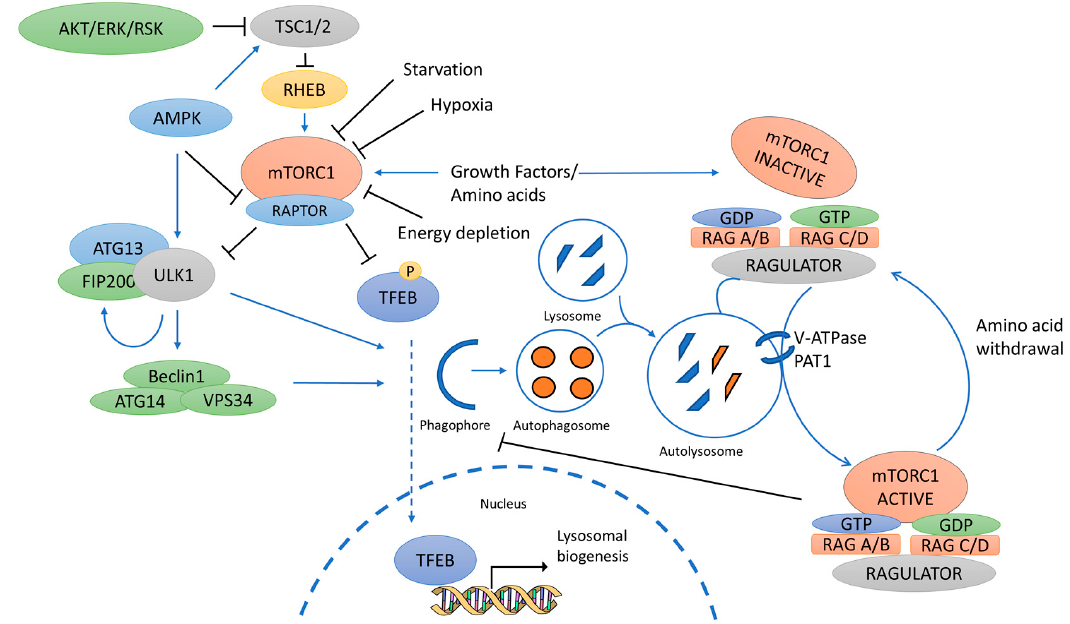
Figure 1. Schematic of key players in the mammalian autophagy pathway discussed in this review. The mechanistic target of rapamycin (mTORC1) is the major control complex for autophagy. A diverse range of signals, such as growth factors and amino acids, regulates mTORC1 by inhibiting the Tuberous sclerosis complex 1 and 2 (TSC1/2), thereby alleviating the inhibitory effect of TSC1/2 on the Ras homolog enriched in the brain (Rheb), which subsequently activates mTORC1. The AMP-activated protein kinase (AMPK) also inhibits mTORC1 via inhibition of the Regulatory associated protein of mTOR (Raptor). mTORC1 is tethered to the lysosomal surface via the Ras-related GTPases (Rags), which activity is regulated by the amino acid sensing of the the vacuolar H + -adenosine triphosphatase ATPase (v-ATPase) and the Proton-assisted amino acid transporter 1 (PAT1). Conversion of GTP-GDP is performed by the GTPase-activating proteins/ Guanine-exchange factor (GAP/GEF) activity of Folliculin (FLCN) and Ragulator. Under nutrient-rich conditions, mTORC1 suppresses autophagy by mediating phosphorylation-dependent inhibition of Unc-51 like autophagy activating kinase (ULK1) and the Transcription factor EB/E3 (TFEB/TFE3). Under starvation, ULK1 activation promotes autophagy initiation and autophagosome maturation, and TFEB/TFE3 promote transcription of genes regulating autophagy and lysosomal